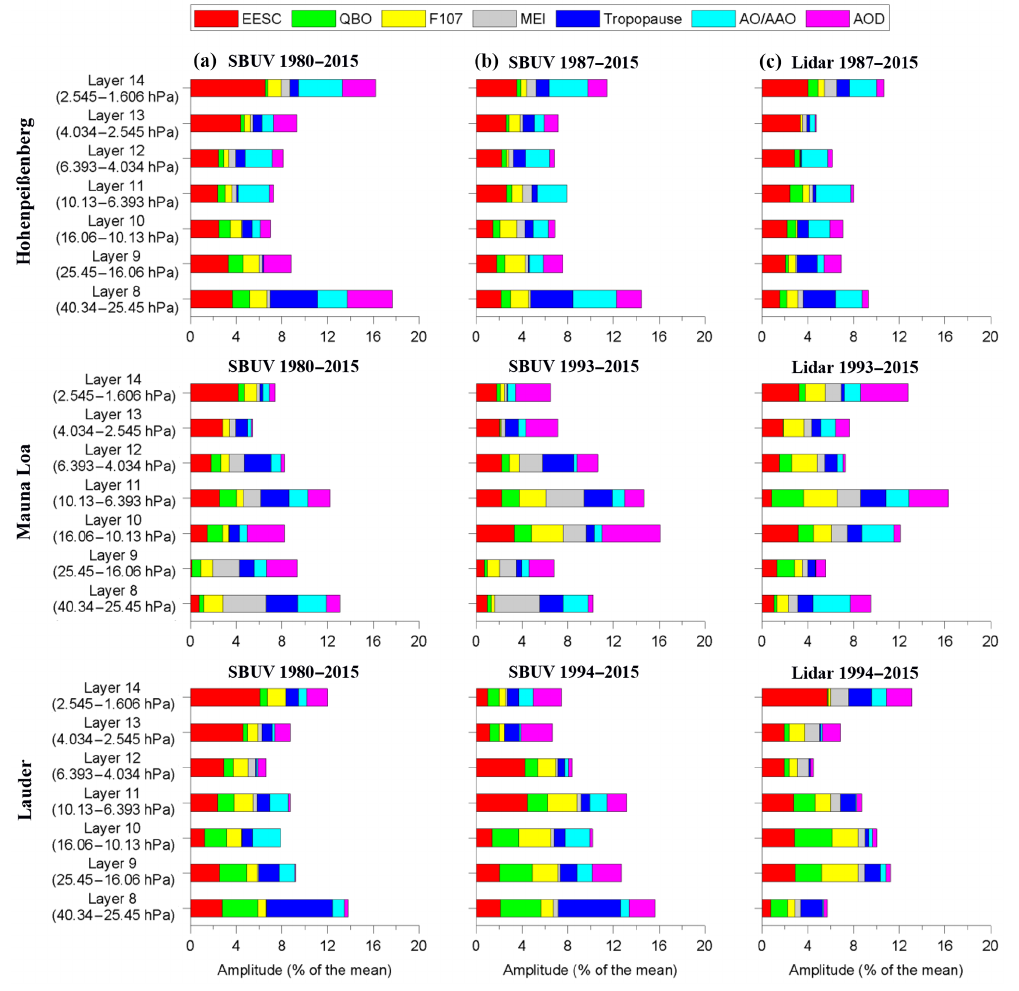
Figure 4. Amplitudes, i.e. (max − min) / 2, of ozone variations attributed to EESC and its orthogonal function, QBO, F10.7, MEI, tropopause pressure, AO (or AAO at Lauder) and AOD for each stratospheric layer. All values are expressed in percent of the long-term mean at each layer. Stations shown are: Hohenpeißenberg (47.8 ◦ N, 11.0 ◦ E), Mauna Loa (19.5 ◦ N, 155.6 ◦ W) and Lauder (45.0 ◦ S, 169.7 ◦ E). (a) SBUV overpass data for the full period 1980–2015. (b) SBUV overpass data for common period with lidar, starting in 1987 at Hohenpeißenberg, 1993 at Mauna Loa and 1994 in Lauder. (c) lidar monthly